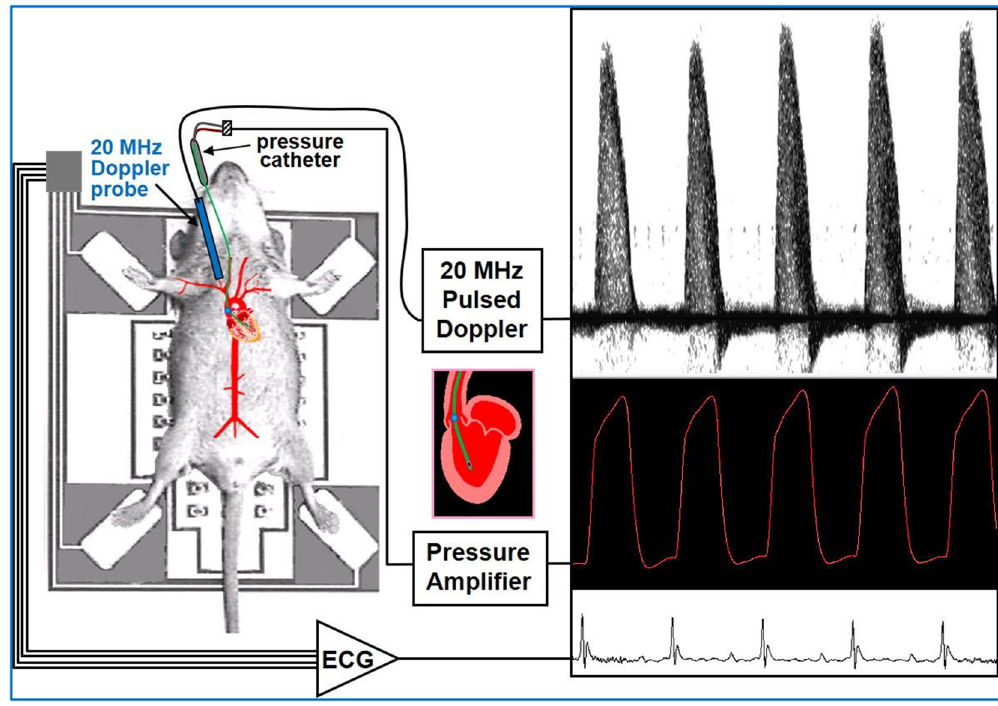
Figure 1. Experimental setup to simultaneously measure ascending aortic flow velocity using DFVS, left ventricular pressure using Millar catheter, and ECG in group 1 mice. Here the 20 MHz Doppler probe is oriented (angle ≤ 20°) towards the ascending aorta with sample volume placed at aortic root. Shown in the plot are ascending aortic outflow velocity (sampled at the site shown by blue dot), LV pressure (sampled at catheter tip in LV), and ECG